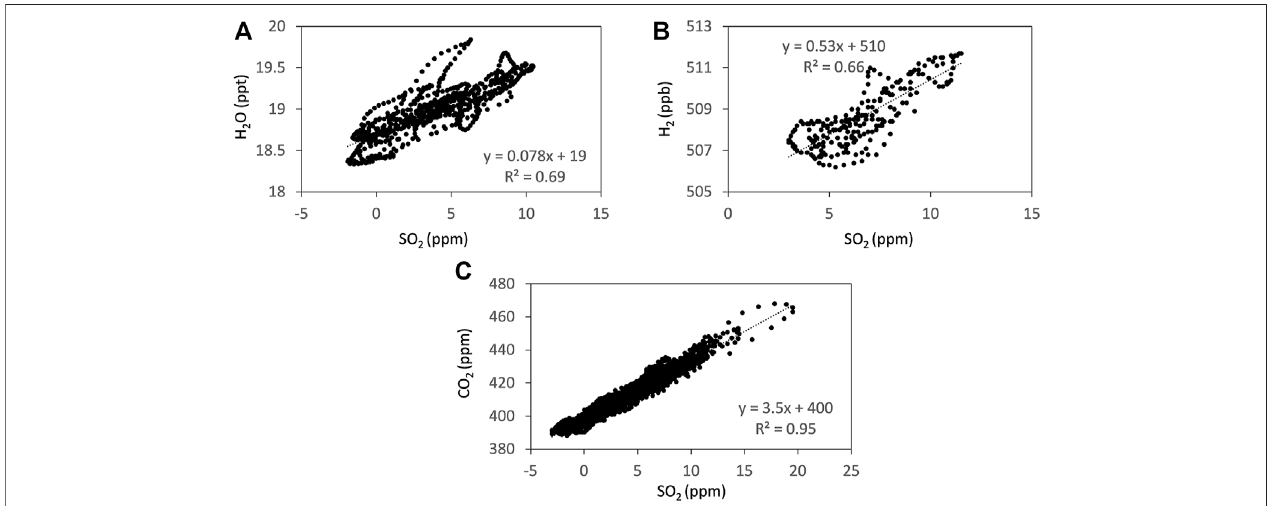
FIGURE 3 | Examples of the correlations from the Ratiocalc analyses (Tamburello, 2015) of SO 2 to H 2 O (A) , H 2 (B) , and CO 2 (C) measured using Mutli-GAS on 13January2018.Thetimeseriesare fi lteredandshiftedtotakethesensorresponseintoaccountusingRatiocalc.H